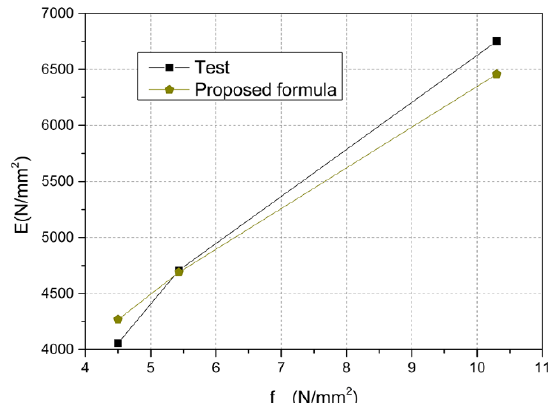
Figure 17. The elastic modulus calculated by the test and the calculation results obtained with the proposed formula.